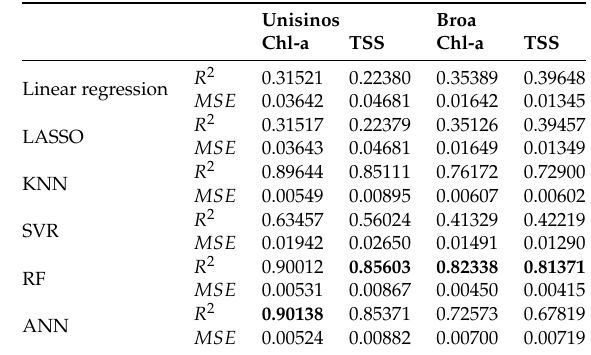
Table 2. Mean values for the evaluated metrics in the cross-validation step. The highest values for R 2 are presented in